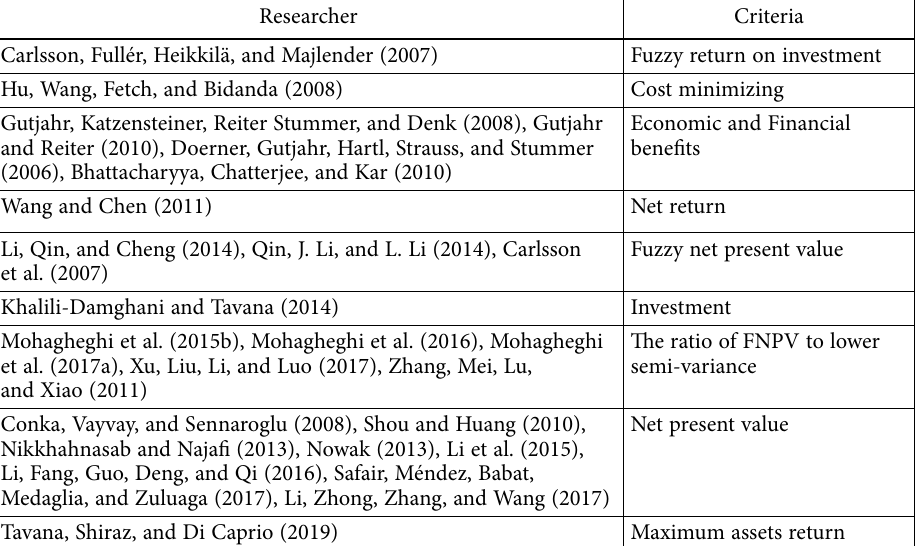
Table 2. Papers using financial criteria Researcher Criteria Carlsson, Fullér, Heikkilä, and Majlender (2007) Fuzzy return on investment Hu, Wang, Fetch, and Bidanda (2008) Cost minimizing Gutjahr, Katzensteiner, Reiter Stummer, and Denk (2008), Gutjahr Economic and Financial benefits and Reiter (2010), Doerner, Gutjahr, Hartl, Strauss, and Stummer (2006), Bhattacharyya, Chatterjee, and Kar (2010) Wang and Chen (2011) Net return Li, Qin, and Cheng (2014), Qin, J. Li, and L. Li (2014), Carlsson Fuzzy net present value et al. (2007) Khalili‐Damghani and Tavana (2014) Investment Mohagheghi et al. (2015b), Mohagheghi et al. (2016), Mohagheghi The ratio of FNPV to lower et al. (2017a), Xu, Liu, Li, and Luo (2017), Zhang, Mei, Lu, semi-variance and Xiao (2011) Conka, Vayvay, and Sennaroglu (2008), Shou and Huang (2010), Net present value Nikkhahnasab and Najafi (2013), Nowak (2013), Li et al. (2015), Li, Fang, Guo, Deng, and Qi (2016), Safair, Méndez, Babat, Medaglia, and Zuluaga (2017), Li, Zhong, Zhang, and Wang (2017) Tavana, Shiraz, and Di Caprio (2019) Maximum assets